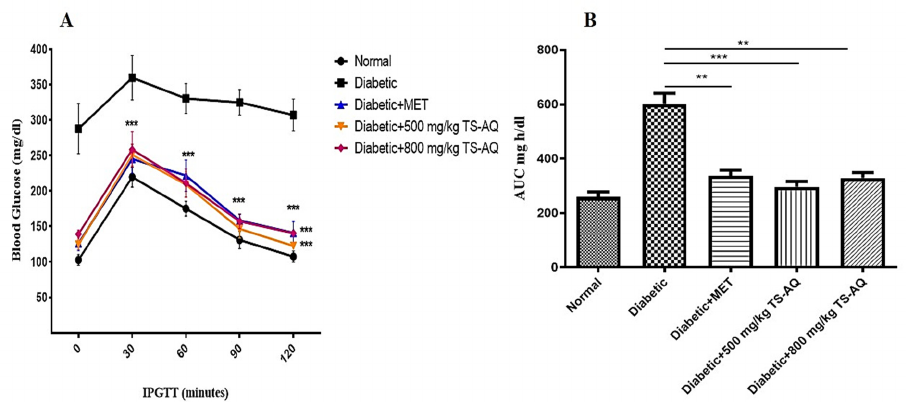
Figure 5. Intraperitoneal glucose tolerance test. ( A ) Blood glucose levels of different groups at 30, 60, 90, and 120 min after intraperitoneal load of glucose (2 g/kg). Before injection, values for the blood glucose levels were considered as 0 min. ( B ) The AUC curve showing the glycemic index for each group. * Depict statistical significance. ** = p < 0.01. *** = p < 0.001. ( n = 10 for each group).